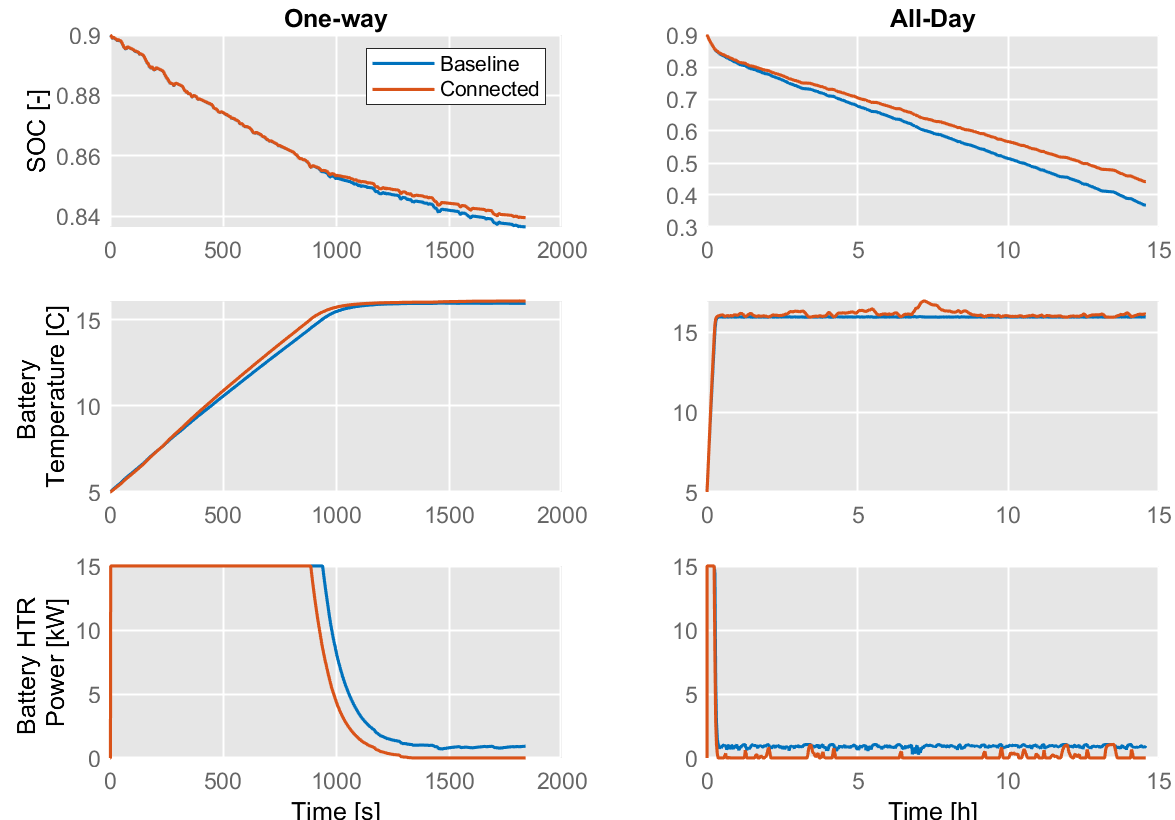
Figure 21. Multivariable comparation between both thermohydraulic configuration throughout time for a one-way journey and all day of bus route 18.